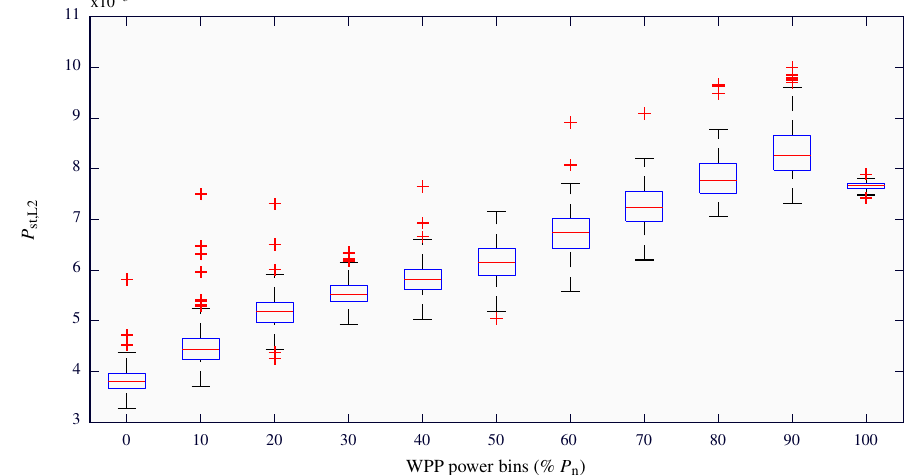
Figure 7. For a ψ k value of 87.34 ◦ , boxplots of the measured P st,L2 values at the PCC (16 WTs) with 14 respect to the power bin of the WPP (32